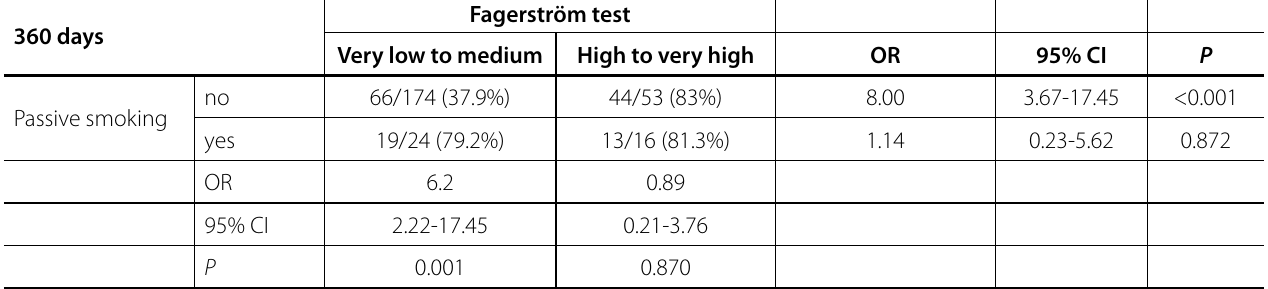
Table 6. Stratified analysis of the interaction between variables "Passive smoking" and "Fagerström test" in the relapse of